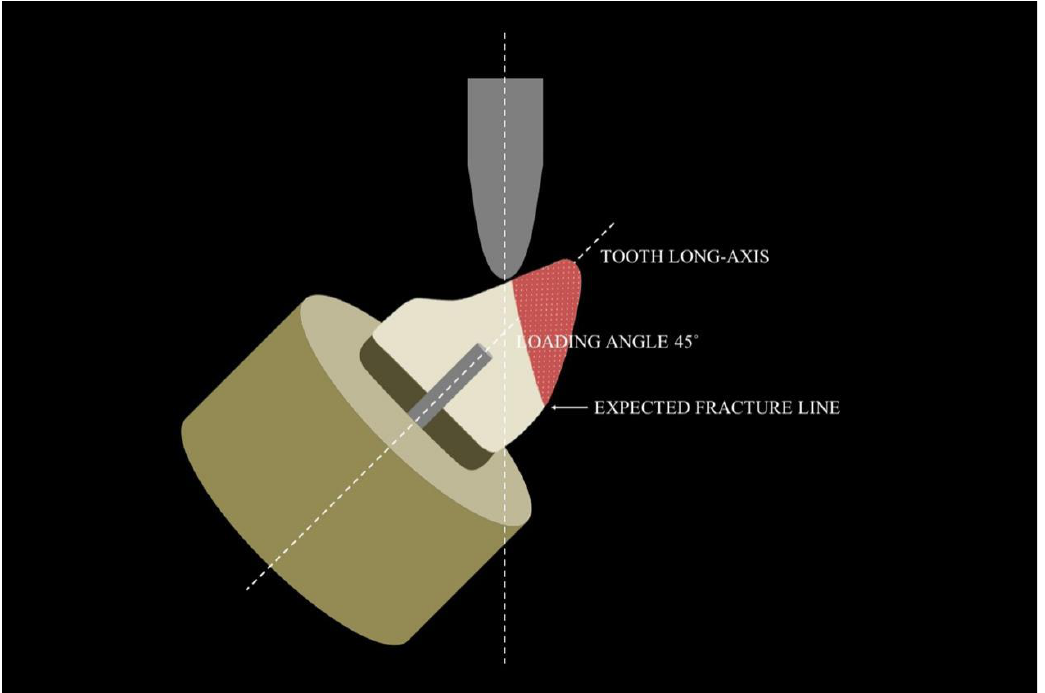
Figure 4. Expected fracture lines according to the loading angles with 45 degrees from the long-axis of the root.